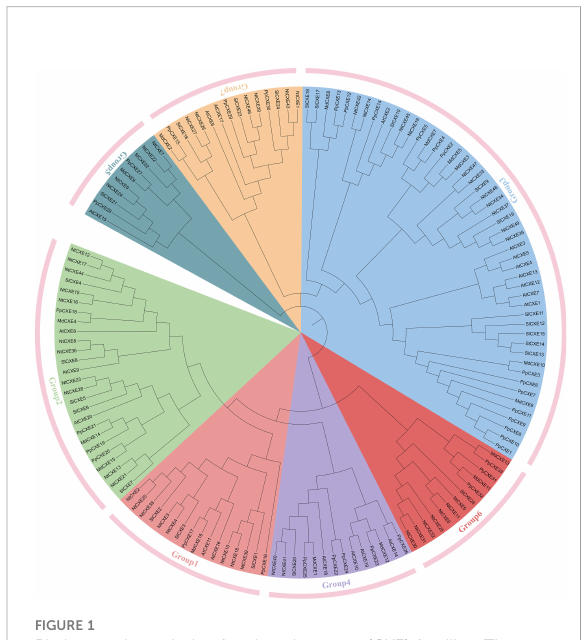
FIGURE 1 Phylogenetic analysis of carboxylesterase (CXE) families. The Neighbour-Joining (NJ) phylogenetic tree was constructed according to amino acid sequences of CXE genes in Arabidopsis , tomato, peach, apple and tobacco by MEGA 7.0. The CXE proteins were divided into seven groups (marked as groups 1-7), distinguished by different colors. The standard value of nodes was derived using bootstrapping, with 1000